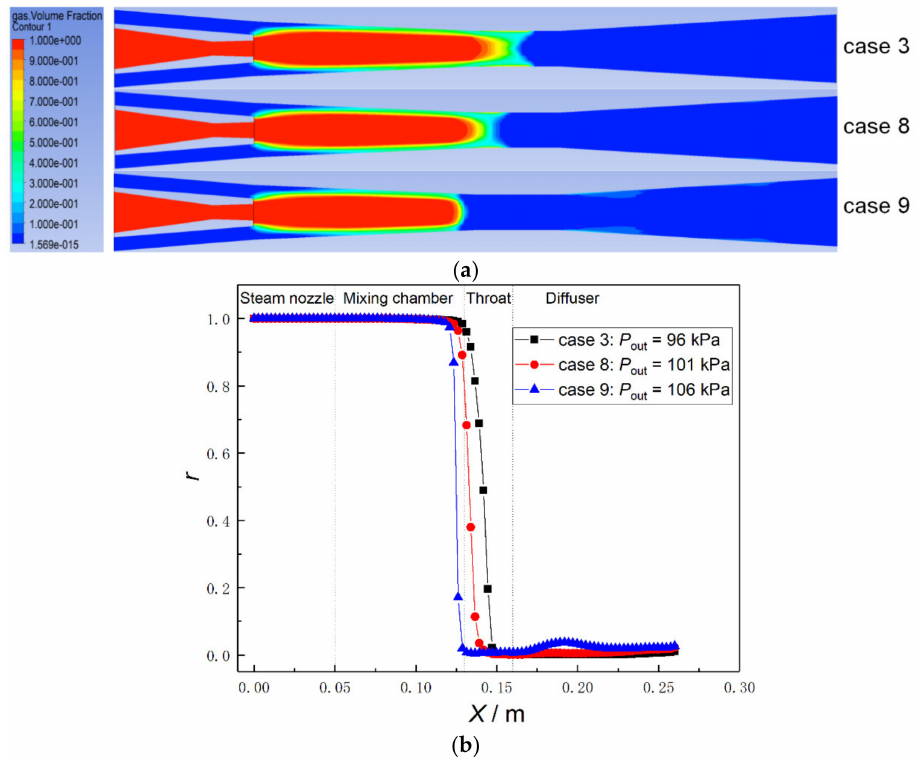
Figure 12. Effect of backpressure P out on steam volume fraction. ( a ) Contours of steam volume fractions at different backpressures; ( b ) Axial steam volume fraction profiles along the centerline at different backpressures.